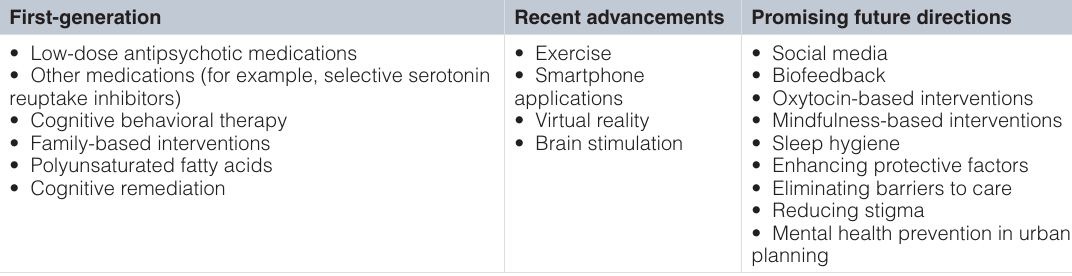
Table 1. Past, present, and future intervention and prevention strategies for psychosis risk